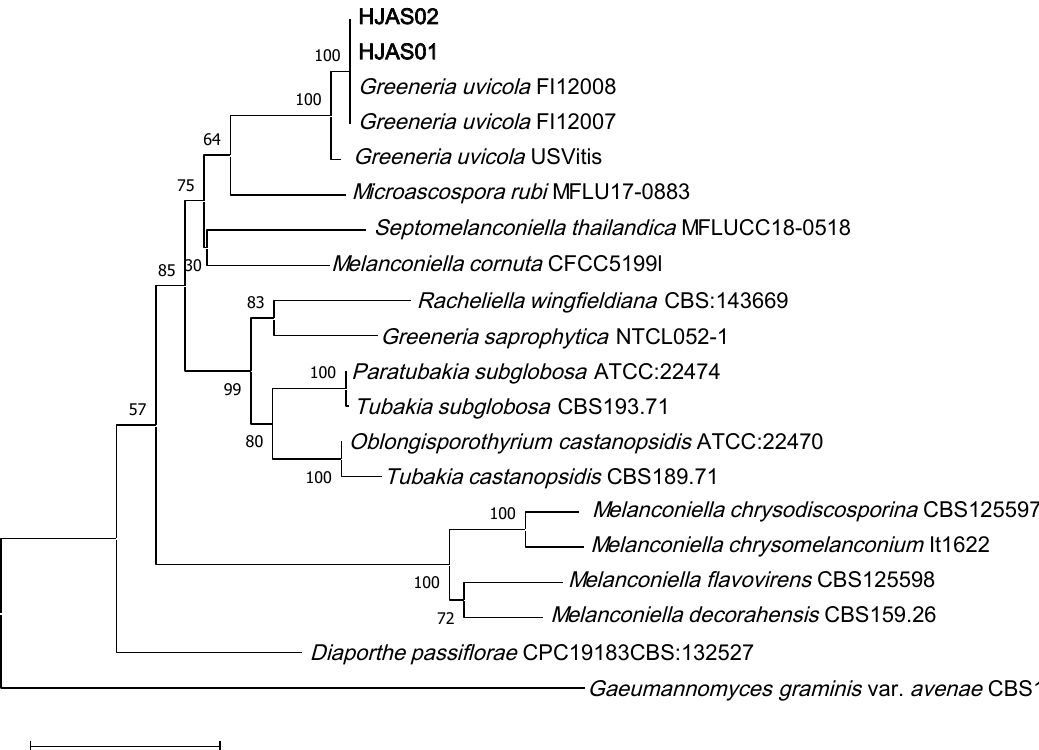
Figure 3. Evolutionary analyses conducted in MEGA X using nucleotide sequences of the ITS-LSU genes. Representative isolates of different Melanconiellaceae family were included, along with two representative isolates (HJAS01 and HJAS02) from grapevines in the Sonora state of Mexico. This analysis involved 20 nucleotide sequences. The evolutionary history was inferred using the Neighbour-Joining method. A total of 1447 positions were in the final dataset. The scale bar represents a genetic distance of